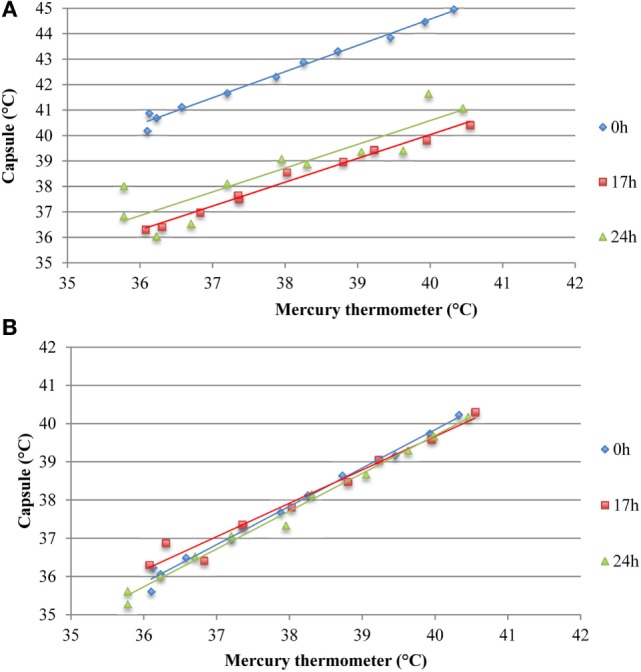
Assessing potential temperature drift over 24 h observed in two capsules measured simultaneously ex vivo. (A) Capsule 11 shows an initial bias at 0 h, which is not present at 17 or 24 h. (B) Temperature readings from capsule 12 were comparable to the mean of two mercury thermometers over 24 h, thereby indicating absence of drift.